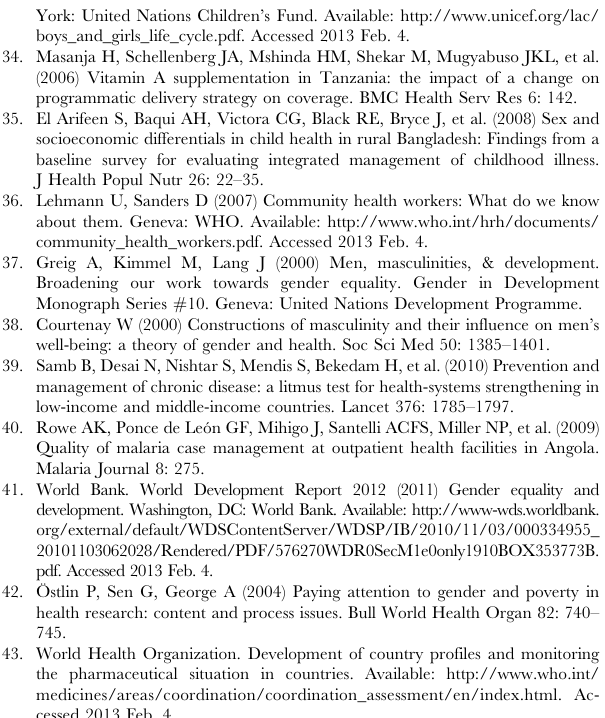
seven countries: a comparison of data from national health examination surveys. Bull World Health Organ 89: 172–183. 29. Damanhori AHH, Al Khaja KAJ, Sequeira RP (2008) Gender-based treatment outcomes in diabetic hypertension. J Postgrad Med 54: 252–258. 30. Ferna´ndez-Liz E, Modamio P, Catala´n A, Lastra CF, Rodrı´guez T, et al. (2007) Identifying how age and gender influence prescription drug use in a primary health care environment in Catalonia, Span. Br J Clin Pharmacol 65: 407–417. 31. Muula AS, Ngulube TJ, Siziya S, Makupe CM, Umar E, et al. (2007) Gender distribution of adult patients on highly active antiretroviral therapy (HAART) in Southern Africa: a systematic review. BMC Public Health 7: 63. 32. Cornell M, Myer L, Kaplan R, Bekker LG, Wood R (2009) The impact of gender and income on survival and retention in a South African antiretroviral therapy programme. Trop Med Int Health 14: 722–731. 33. UNICEF (2011) Boys and girls in the life cyle: sex-disaggregated data on a selection of well-being indicators, from early childhood to young adulthood.